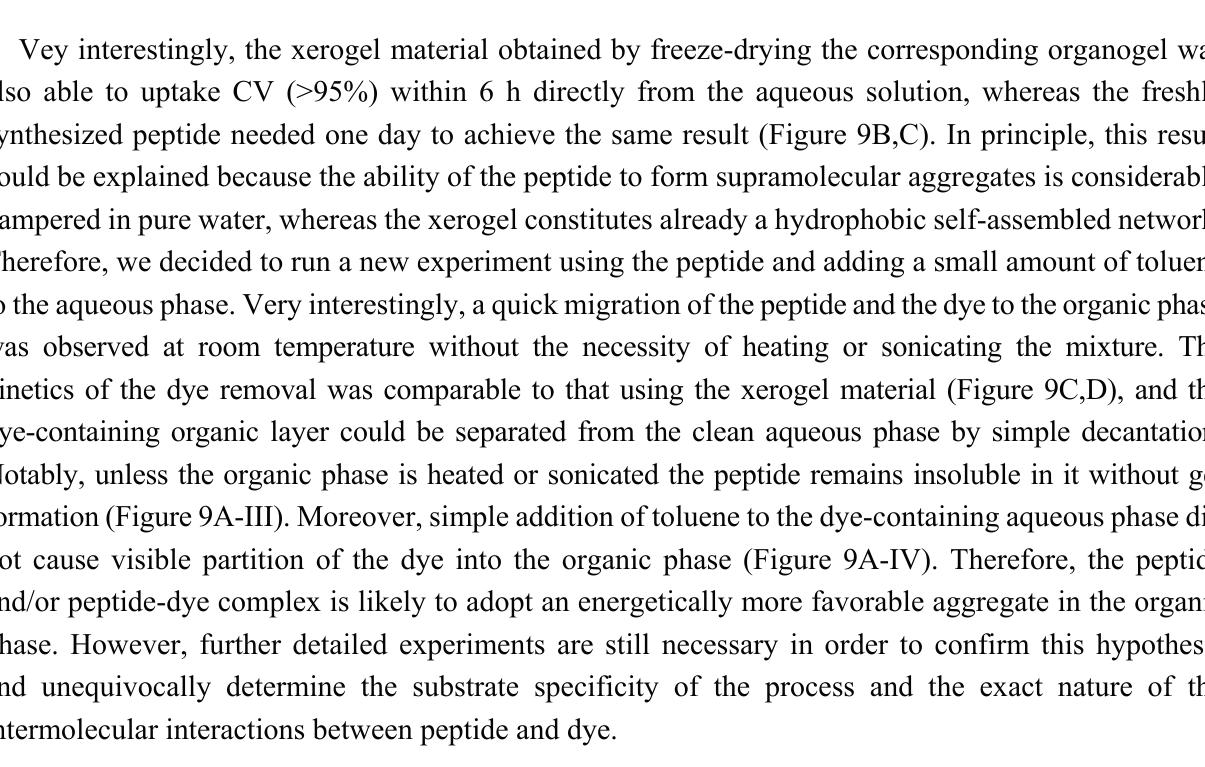
Figure 8. ( A ) Photographs illustrating the removal of crystal violet from an aqueous solution ( c = 1 × 10 − 5 mol·L − 1 ) by addition of toluene (left vial, water/toluene 1:1 v / v ) and gelator bis-A4 (1.0% w / v ). PSG was induced by heating-cooling (H-C) treatment (right vial); and ( B ) UV-vis absorption spectra of the initial aqueous solution of crystal violet ( t = 0 min; blue line) and of the aqueous phase after PSG ( t = 15 min; red